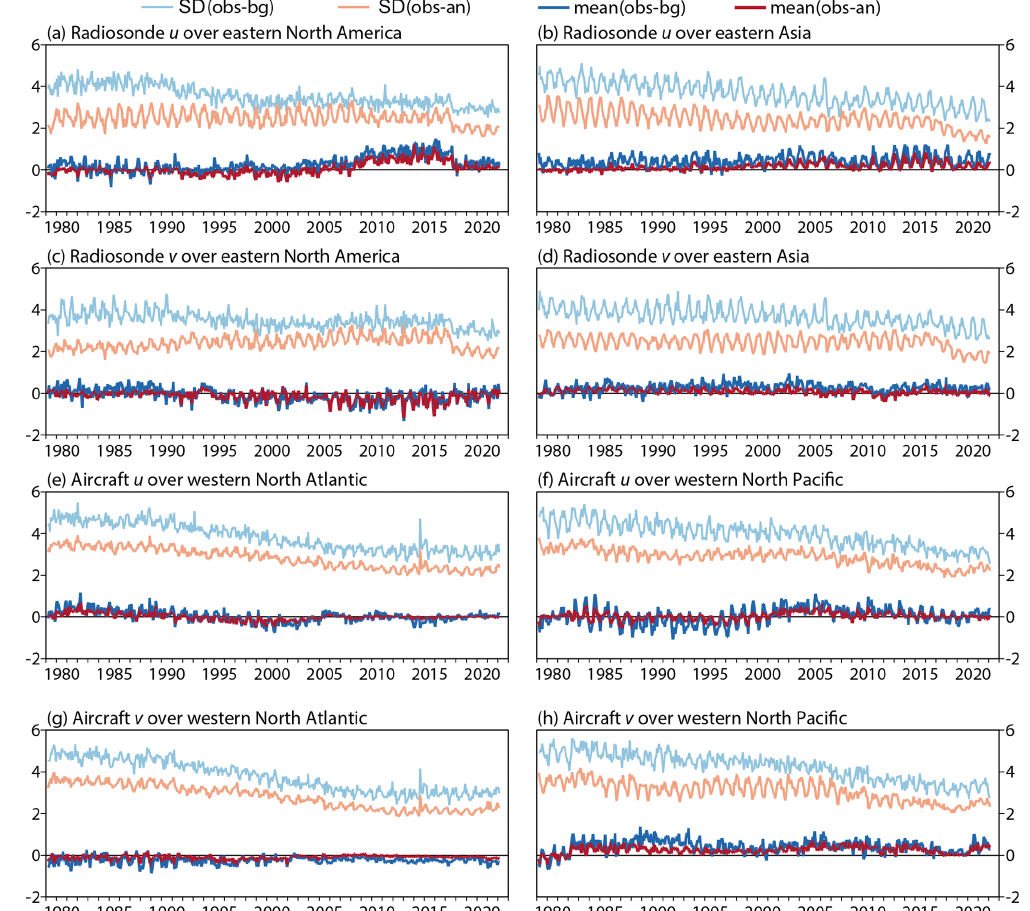
Figure 15. Monthly means and standard deviations of observation minus background (dark and light blue) and observation minus analysis (orange and red) departures (ms − 1 ) for the 175 to 225hPa layer, from March 1979 to February 2022, for zonal ( u ) and meridional ( v ) wind components from radiosondes over the regions (a, c) 35 to 55 ◦ N and 80 to 50 ◦ W and (b, d) from 25 to 45 ◦ N and 115 to 145 ◦ E and from aircraft over the regions (e, g) from 35 to 55 ◦ N and 60 to 30 ◦ W and (f, h) from 25 to 45 ◦ N and 145 to 175 ◦